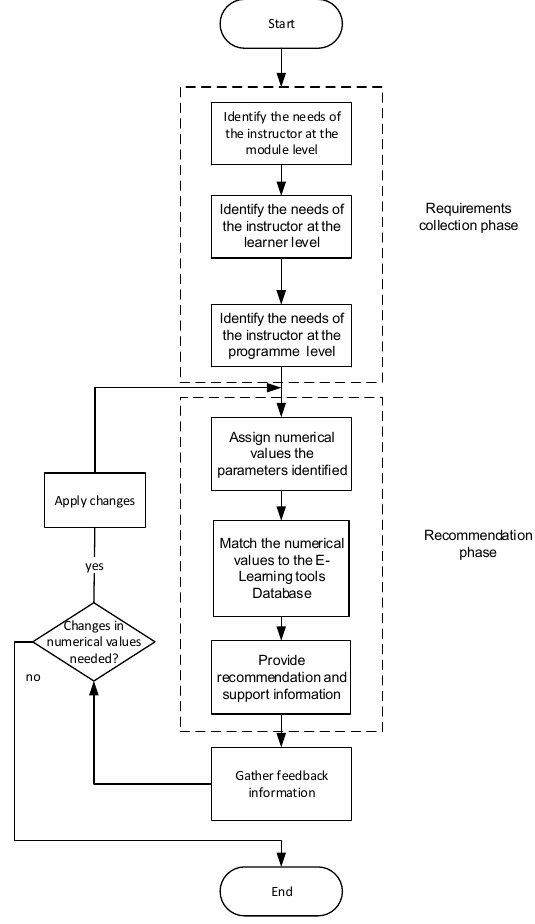
Figure 1. Suitability assessment